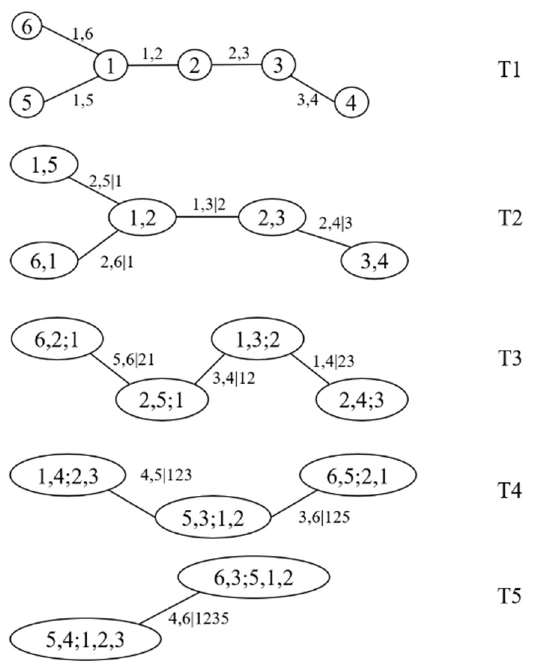
Figure 4. R-vine structure of weight.